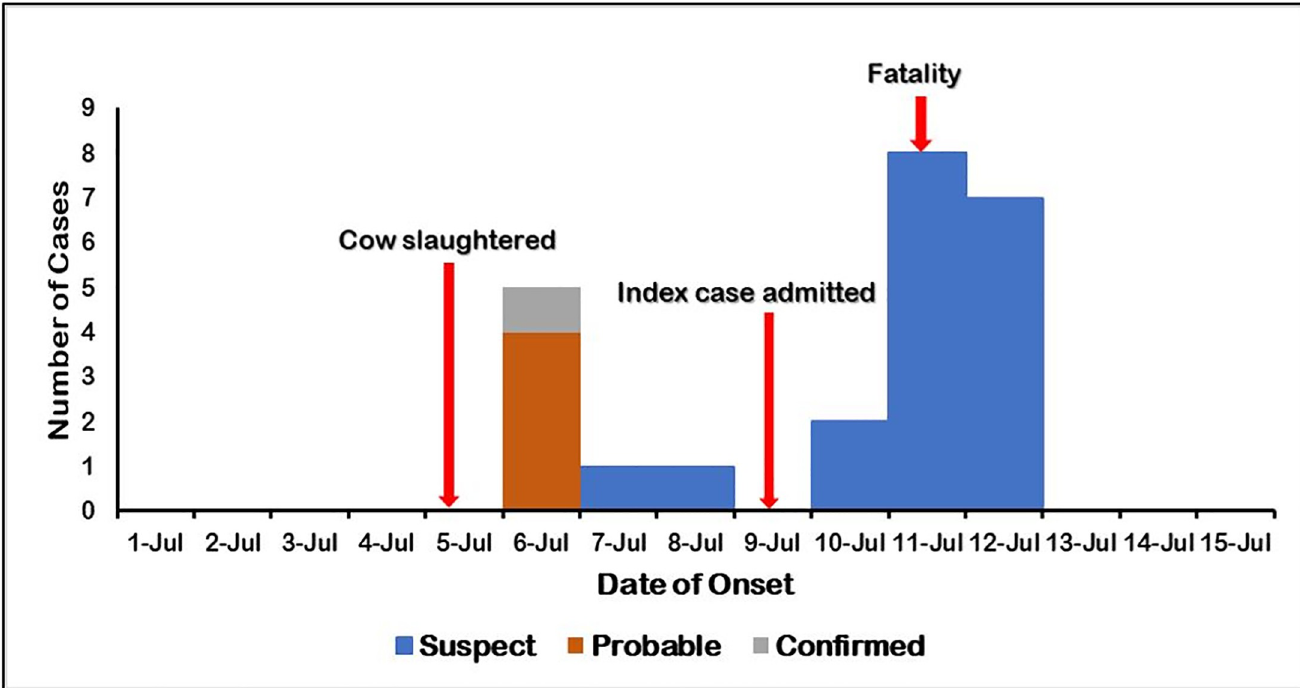
Fig 1. Epidemic curve for anthrax outbreak, Kisumu East Sub County, July 2019.